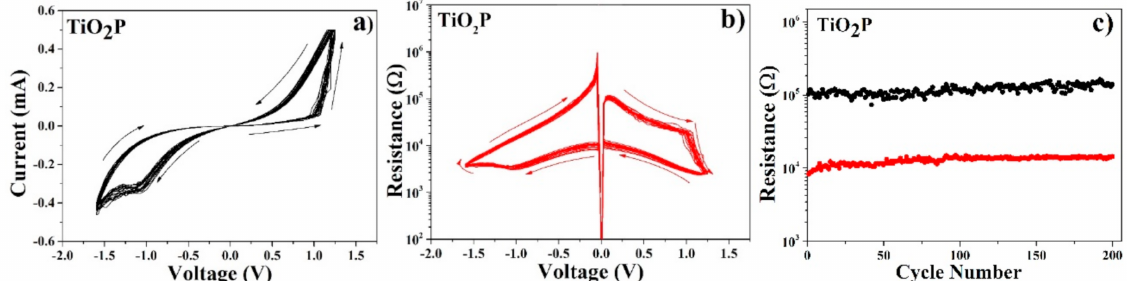
Figure 4. Typical electrical characteristics of TiO 2 P device, having Pt discs as a top electrode. I-V ( a ), R-V ( b ) curves together with device life ( c ; R OFF black dots, R ON red dots).